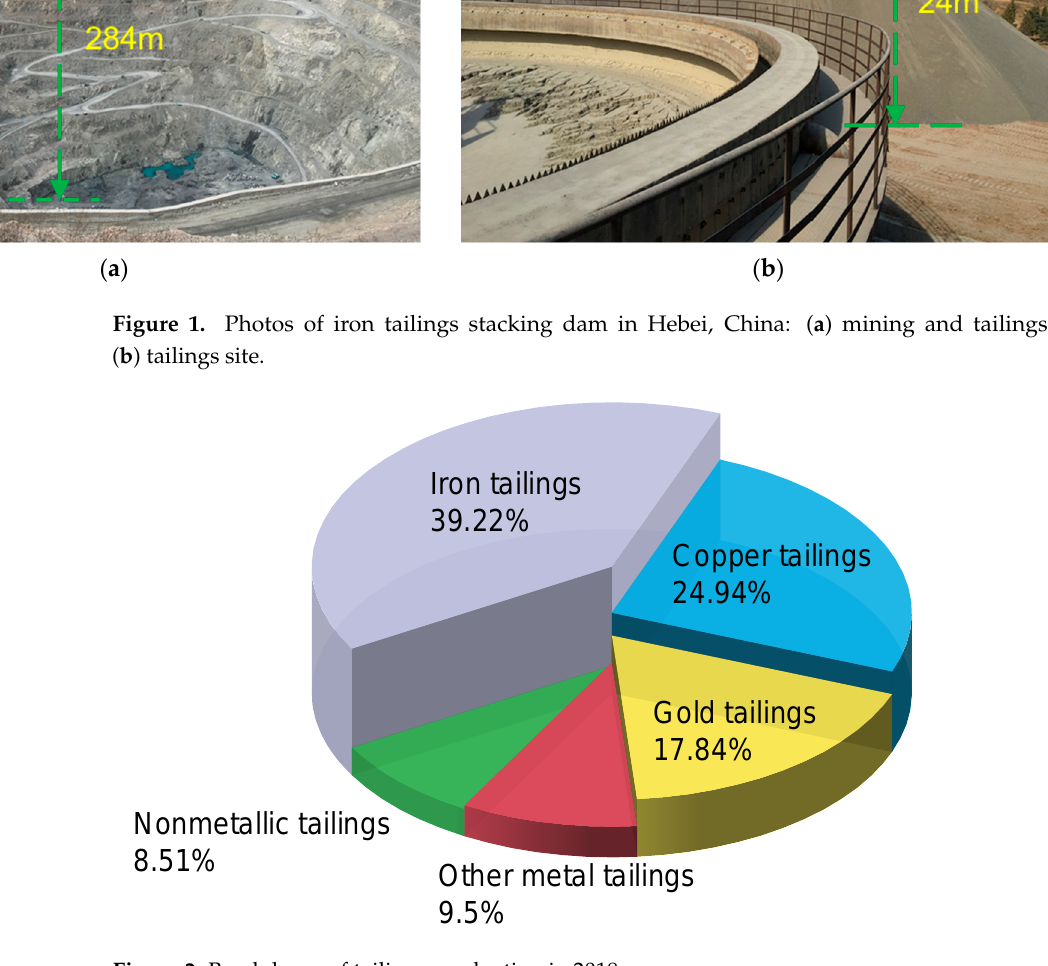
Figure 2. Breakdown of tailings production in 2018.